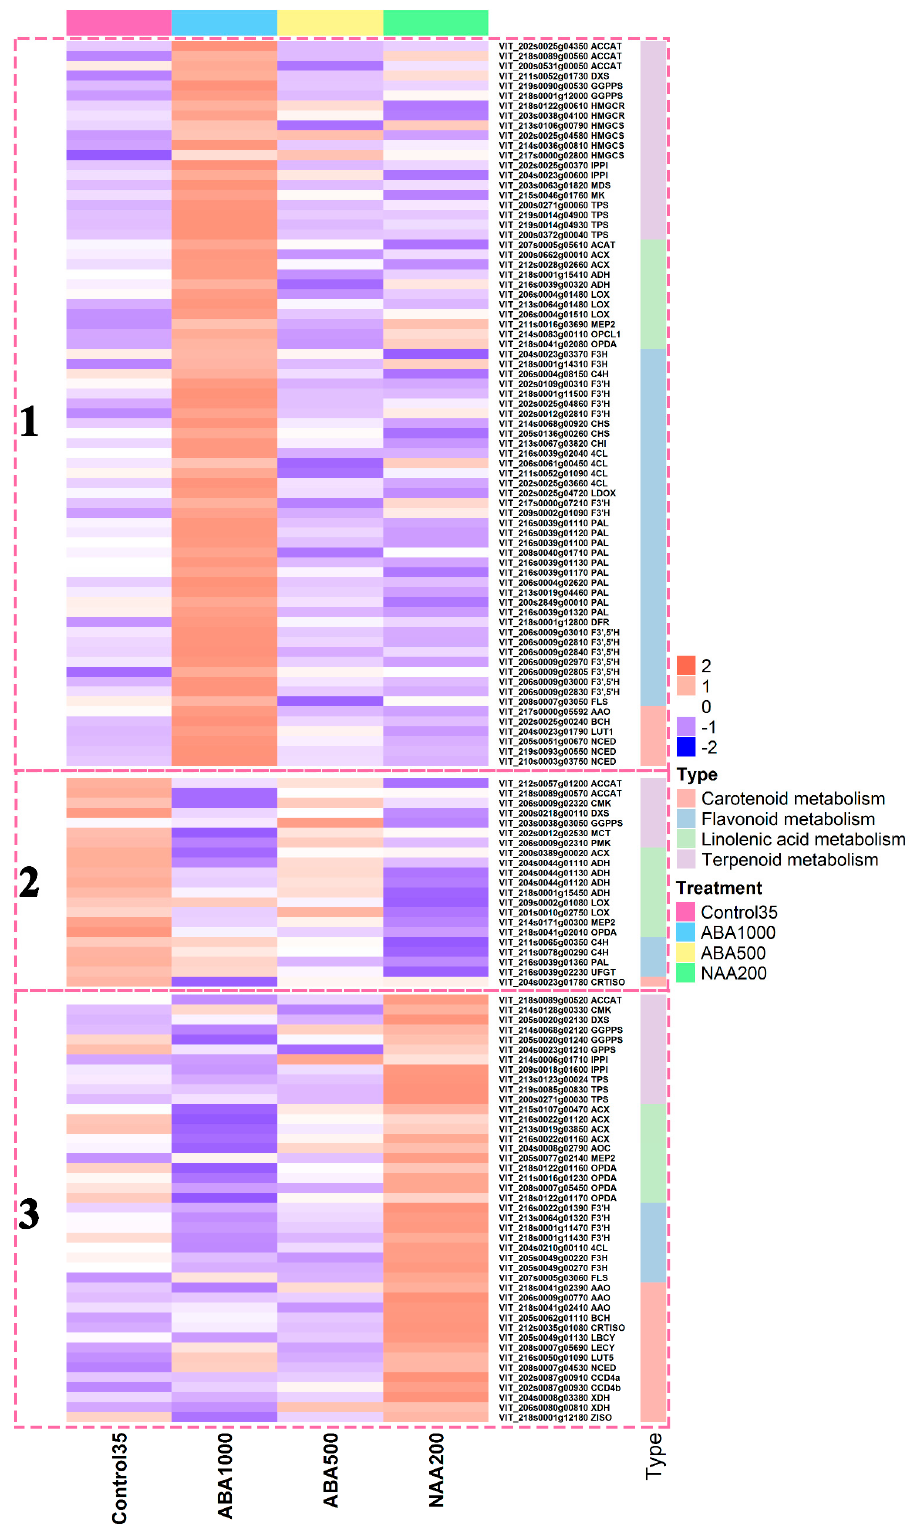
Figure 10. Heatmap analysis of gene involved in carotenoid, flavonoid, linolenic acid, and terpenoid metabolism and hierarchical clustering. Genes are grouped into three clusters by k-means cluster